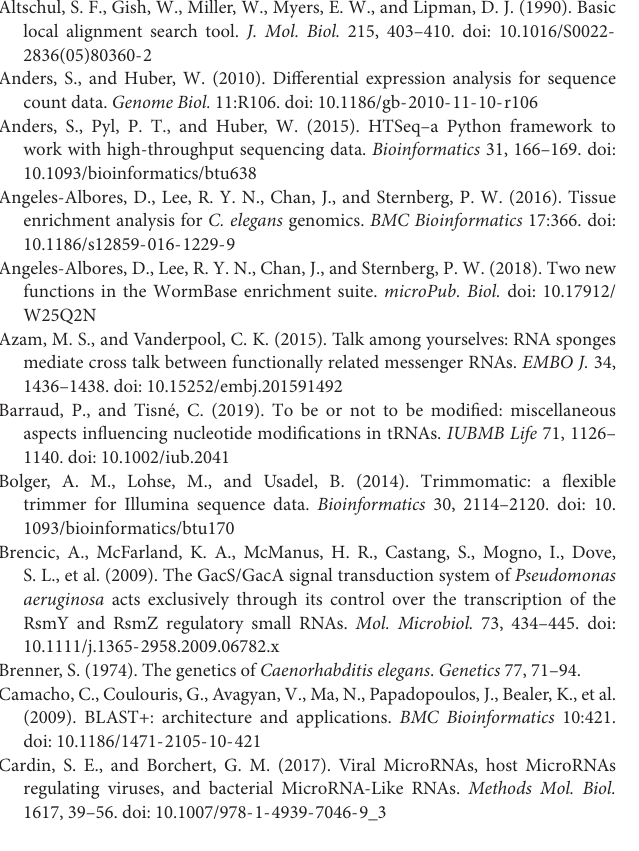
compared to naïve bacteria. Supplementary Table 4 | All transcripts expressed in intestinal conditions with their lengths. Lists of all genes expressed in any of the F1, F2, F5, and F6 generations of C. elegans and further subdivisions as induced and microRNA-sized. Supplementary Table 5 | Transcripts constitutively expressed with their lengths. Supplementary Table 6 | Caenorhabditis elegans mRNA putative targets of microRNA-sized-induced sRNAs from P. aeruginosa PAO1. Supplementary Table 7 | List of C. elegans mRNA targets of P. aeruginosa miRNA-like sRNAs expressed intestinally in C. elegans . Supplementary File 1 | All putative interactions of microRNA-sized host-induced sRNAs with C. elegans mRNAs downregulated during interaction with P. aeruginosa PAO1. Supplementary File 3 | Data for construction of the RNA interactome